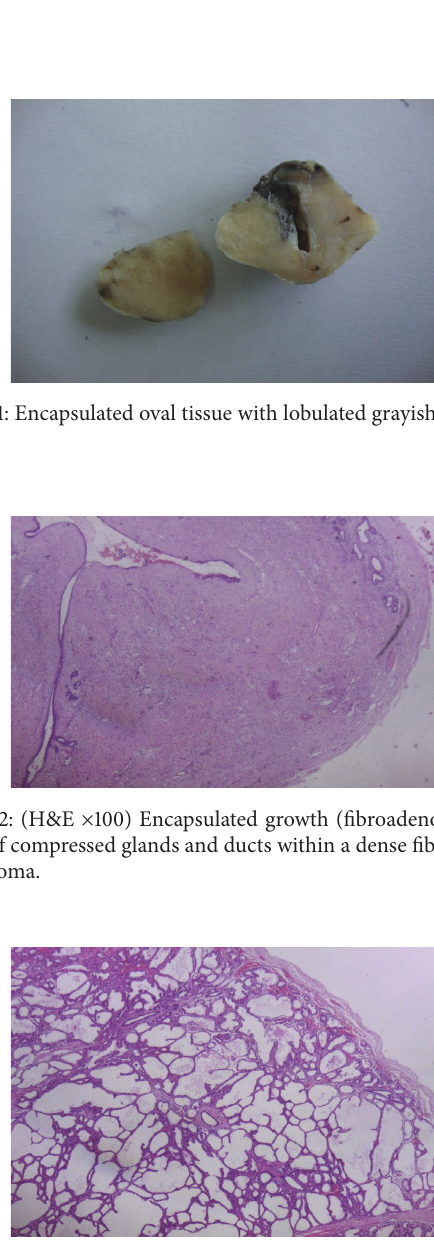
Figure 3: ( × 100) Encapsulated breast lesion showing dilated glands and ducts with secretory activity.